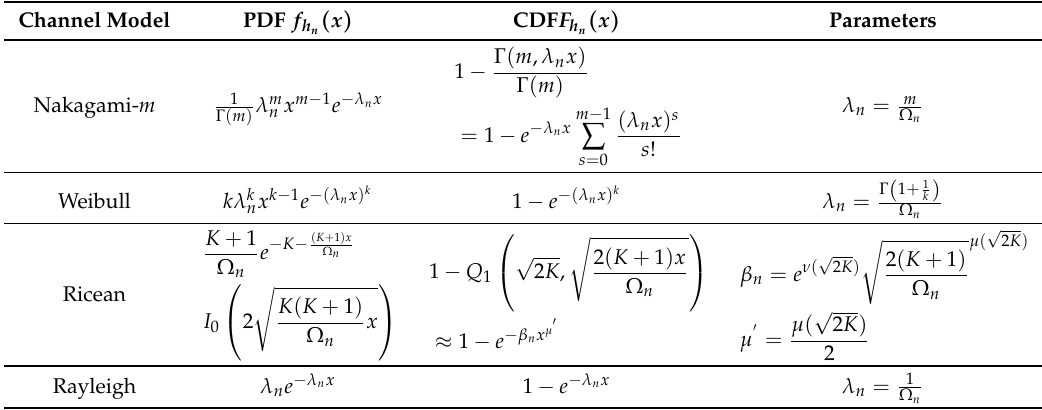
Table 2. PDF and CDF of the channel power gain in different fading